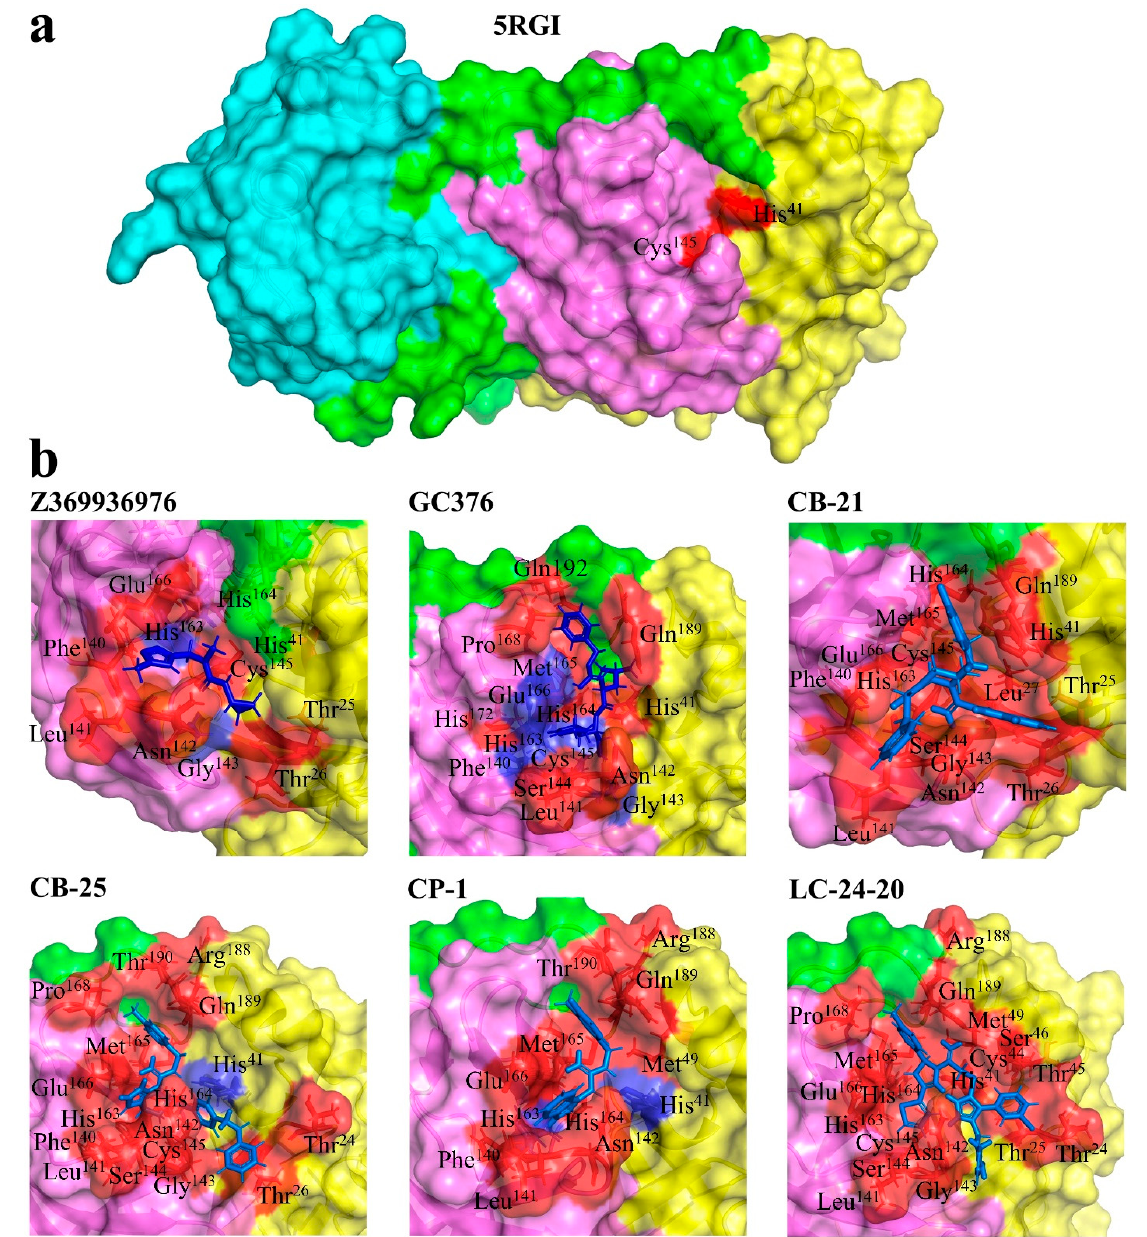
Figure 2. Structure of main protease and interactions with each compound. Main protease has three domains. Domain I (residues 8–101) is colored in yellow, domain II (residues 102–184) is colored in violet and domain III (residues 201–303) is colored in cyan. ( a ) Surface plot of crystal structure 5RGI.